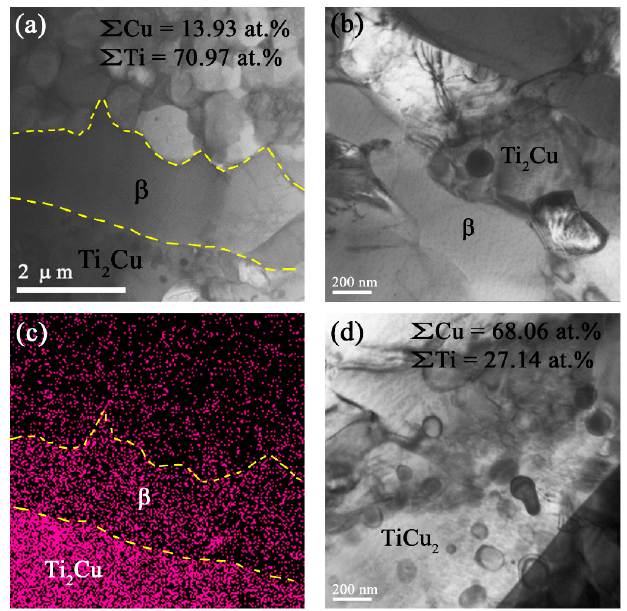
Figure 10. The SZ2 Ti6Al4V/Cu microstructures with dynamically and statically recrystallized α and β grains: Ti 2 Cu coarse grains ( a , b ), EDS map of the copper distribution ( c ), and copper-rich TiCu 2 phase regions with dislocation loops, ( d ) – TiCu 2 IMCs in Cu-rich areas.